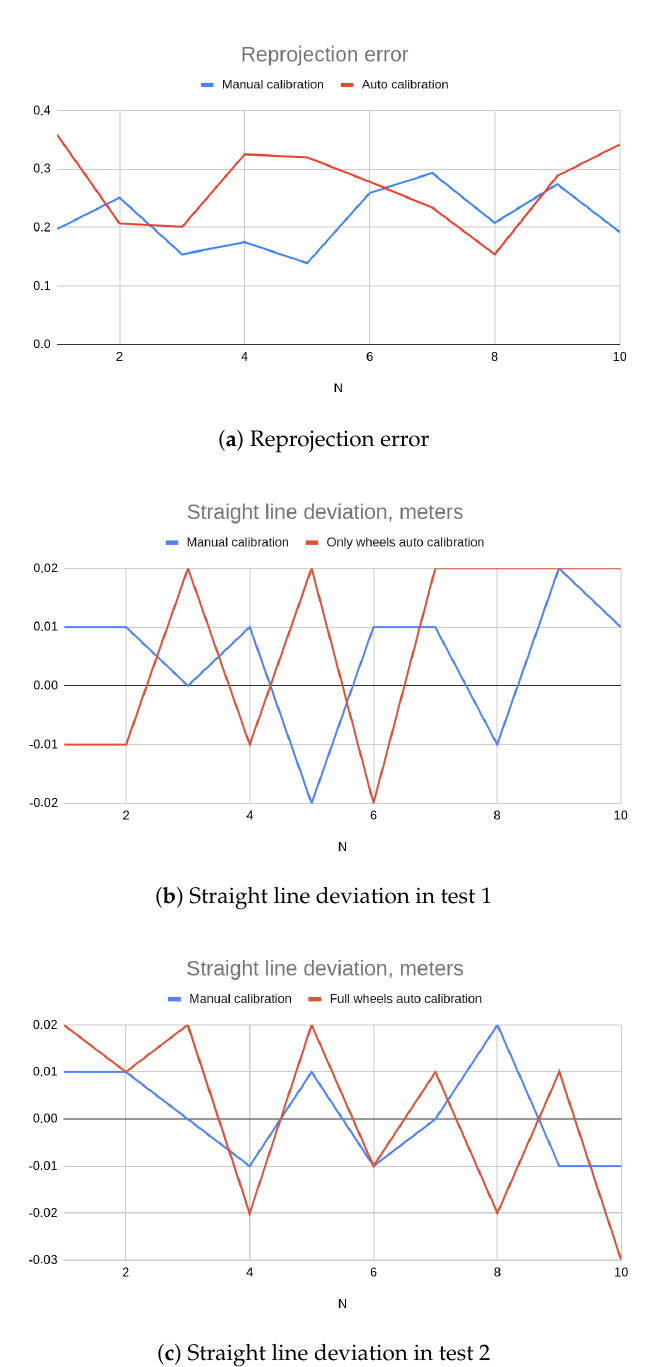
Figure 4. Reprojection error and straight line